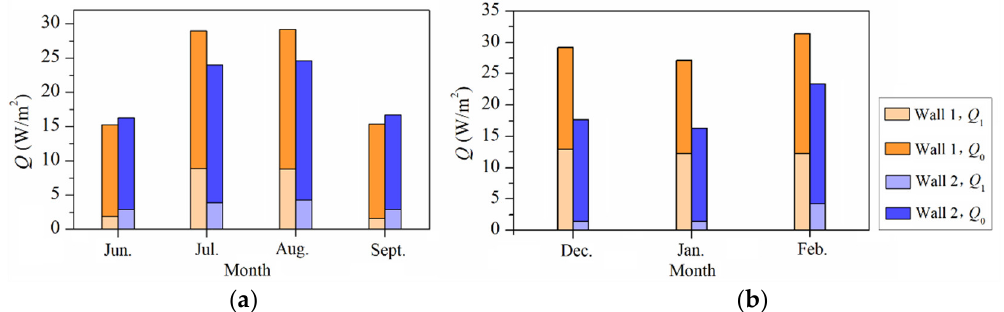
Figure 13. Effect of insulation form on transmission load and total loads for different month; ( a ) in cooling season; ( b ) in heating season.